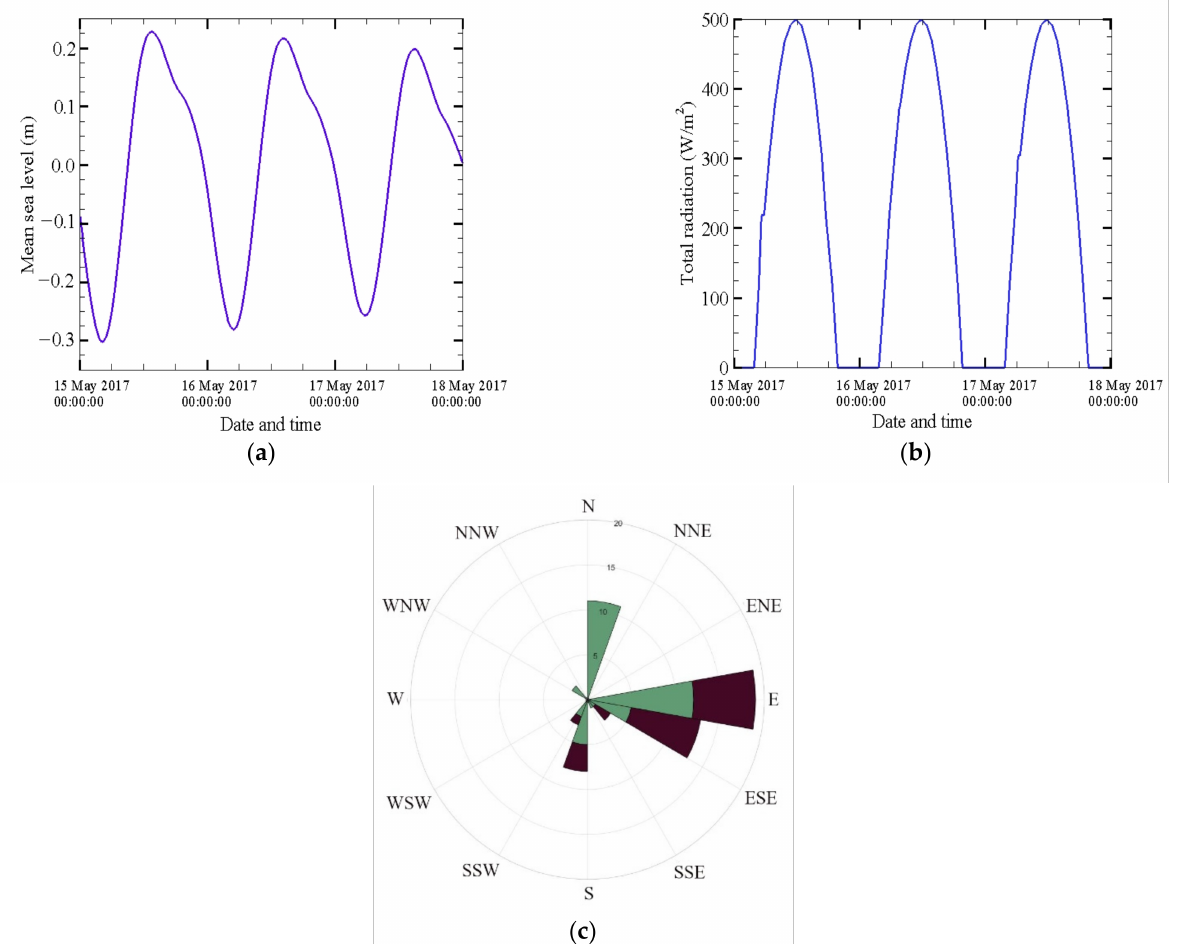
Figure 5. Metocean data: ( a ) tidal variation; ( b ) total solar radiation; ( c ) wind rose for the simulation period (wind speed in